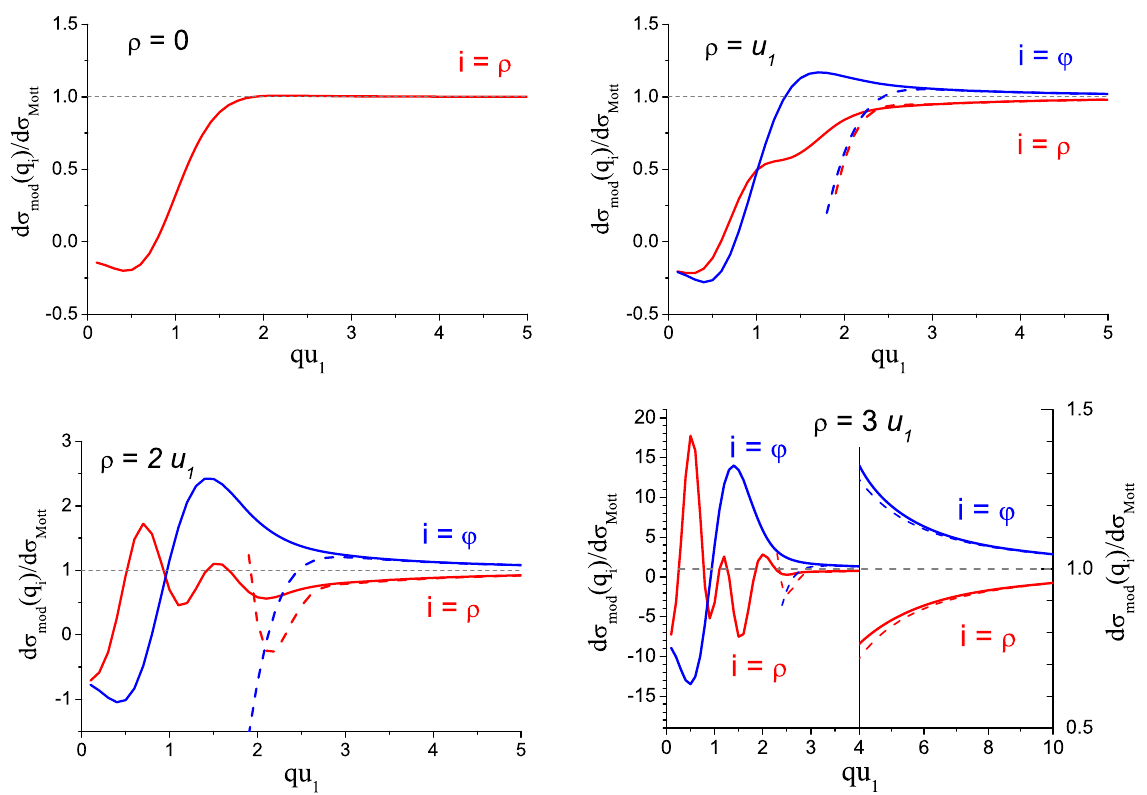
FIG. 4. Modified cross section dependence on momentum transfer for radial ( i ¼ ρ ) and azimuthal ( i ¼ φ ) scattering directions, evaluated using the sign-corrected general (9) (solid) and asymptotic (10) (dashed lines) formulas for the radial coordinates ρ ¼ 0 (top left), ρ ¼ u 1 (top right), ρ ¼ 2 u 1 (bottom left) and ρ ¼ 3 u 1 (bottom right) of the scattering